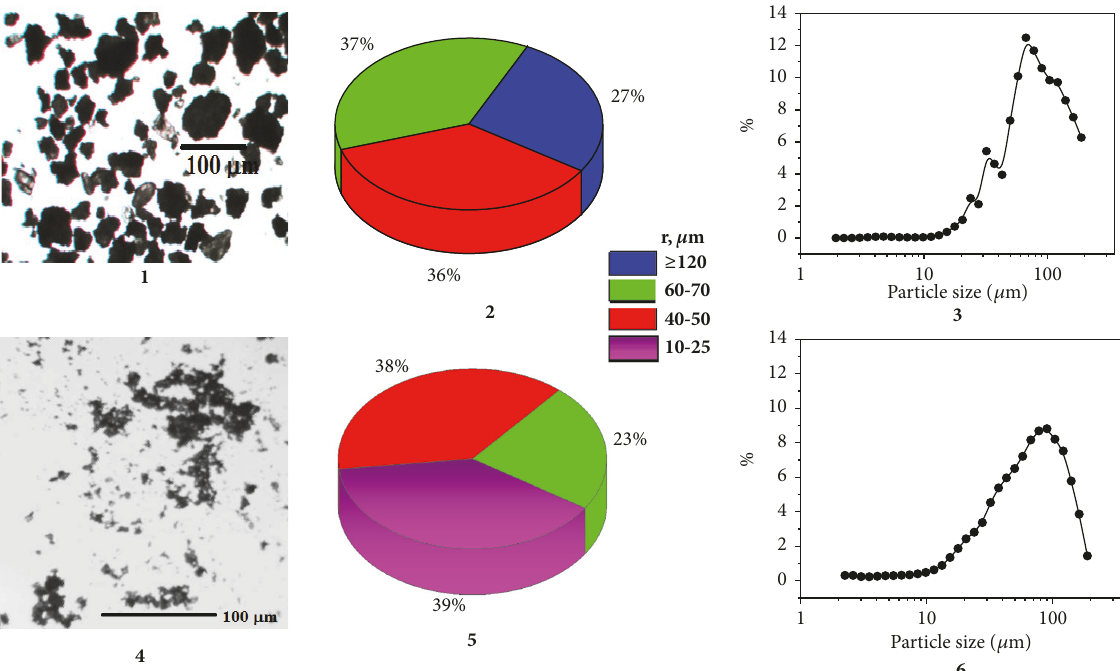
Figure1:Particlesizedistribution(opticalmicroscopy1,2;4,5andlaserdiffraction3,6)ofnative(1-3)anddispersed(4-6)lactosemonohydrate powders (SuperTab 30G). Granulometric analysis of the lactose monohydrate suspension by laser diffraction method (volume distribution, measurement interval from 1 to 120 𝜇 m) was carried out immediately after applying 0.6 g of the substance into 3 ml of water (n ≥ 3, a <